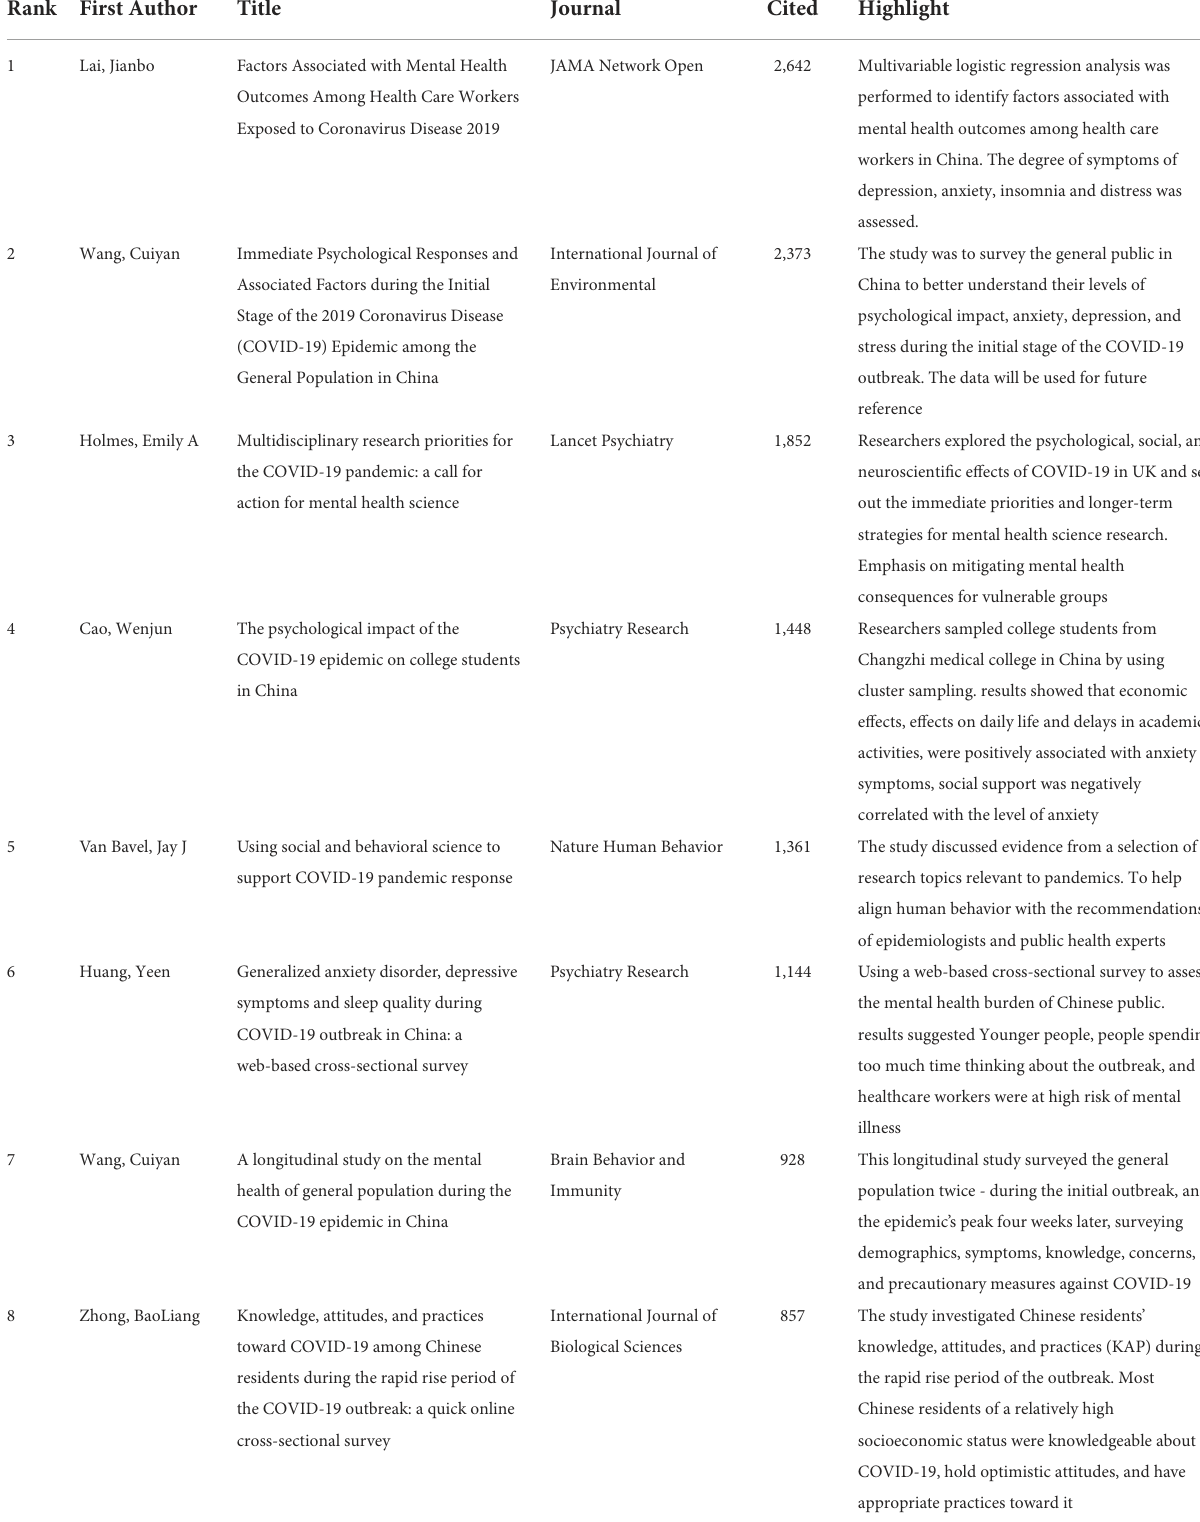
TABLE 2 Top 10 most cited articles on mental health research related to